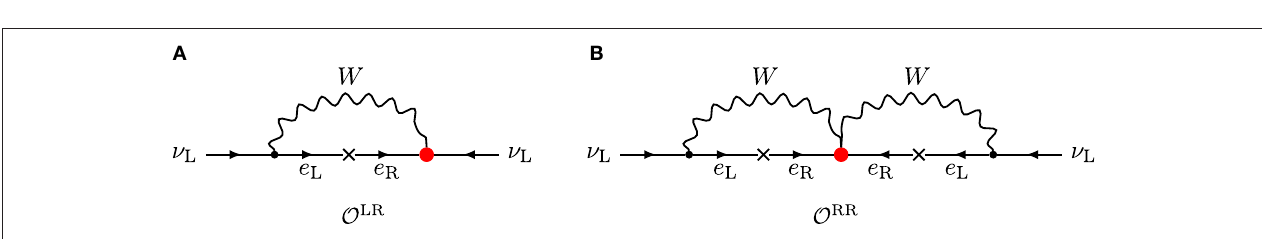
2 effective vertex. Figure reproduced from del Aguila [349]. =